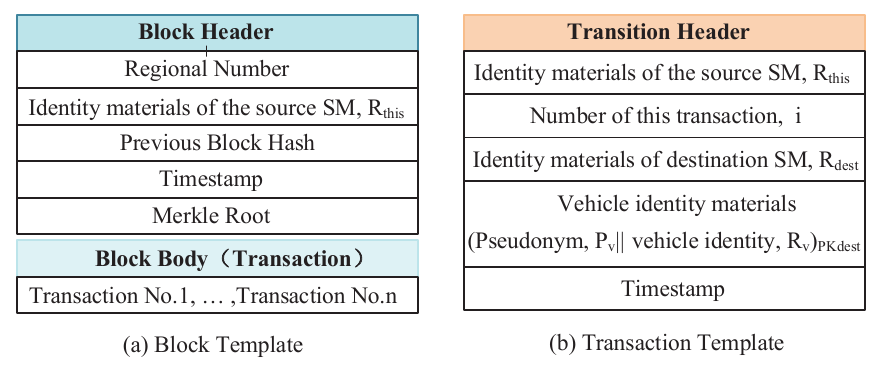
Figure 2. Block template and transaction